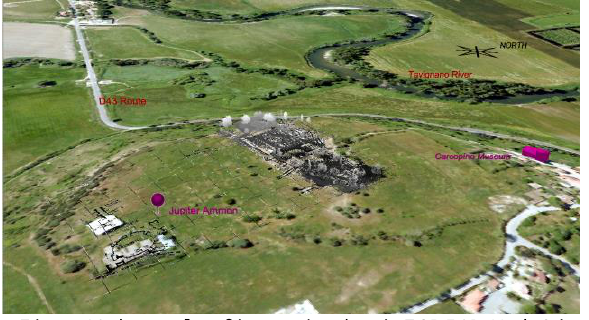
Figure 10 the results of integrating data in ESRI 3D Web